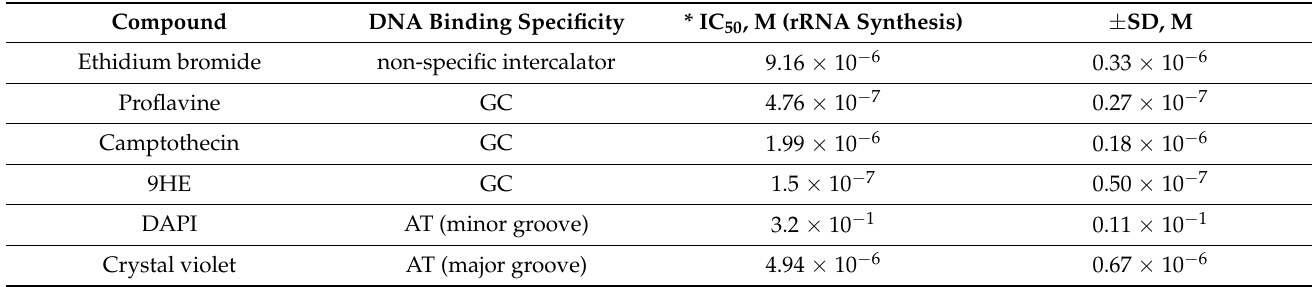
Table 2. In vivo IC 50 concentrations for a selection of DNA intercalators/groove